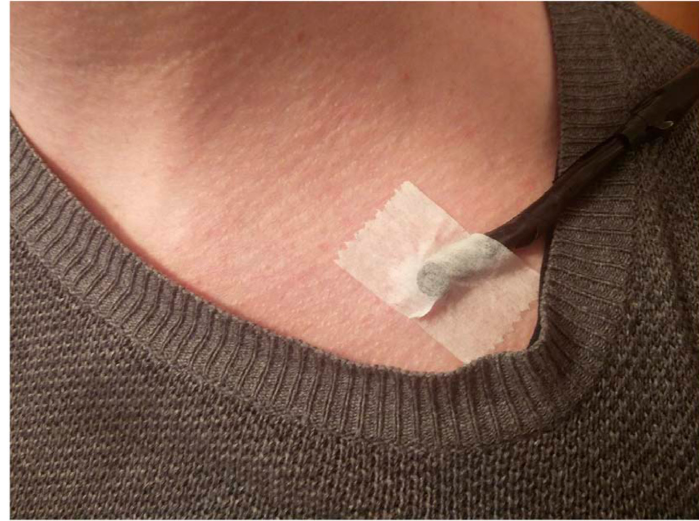
Figure 4. Tactile Detection-Response Task (TDRT) set-up [24].